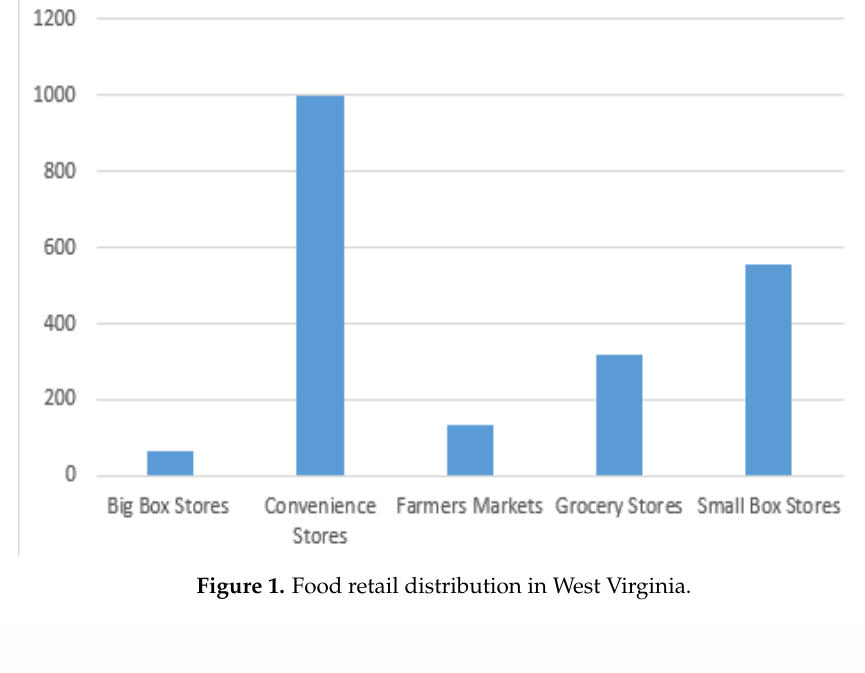
Figure 1. Food retail distribution in West Virginia.